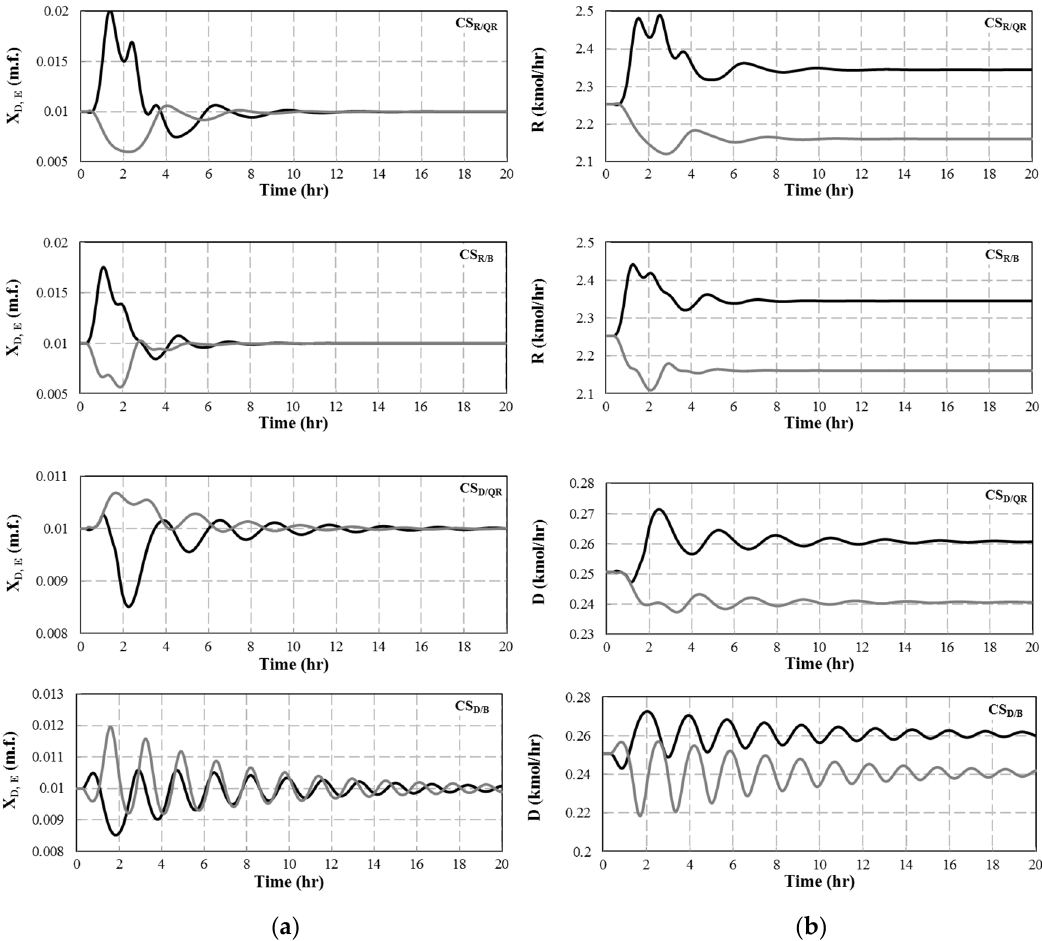
Figure 8. Dynamic responses of the top control loop of the MEPB Kaibel distillation column controlled, respectively, under the CS R / QR , CS R / B , CS D / QR , and CS D / B structures after facing a ± 5% variation in feed flow rate ( + 5%: black curves and − 5%: grey curves): ( a ) controlled variables; ( b ) manipulated variables. Table 4. IAE of the Controlled Components for a ± 5% Variation in Feed Flow Rate.